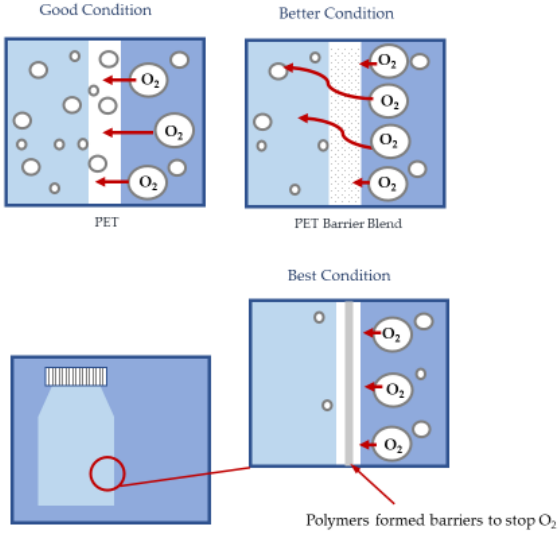
Figure 4. Efficient oxygen barrier guard, recreated from Lingle [84].